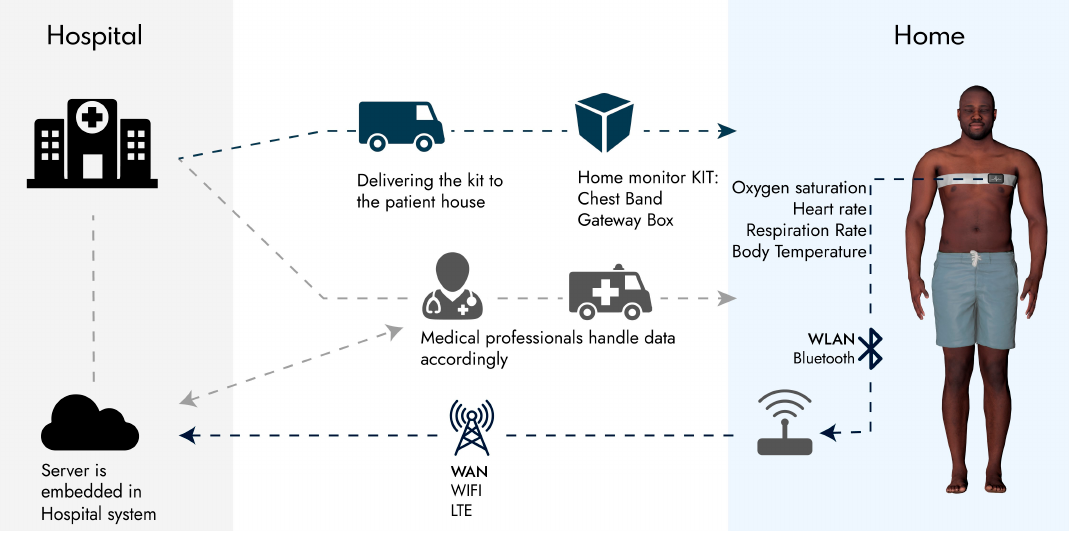
Figure 12. A proposed implementation for the IoMT system adapted to the pandemic caused by Covid-19.